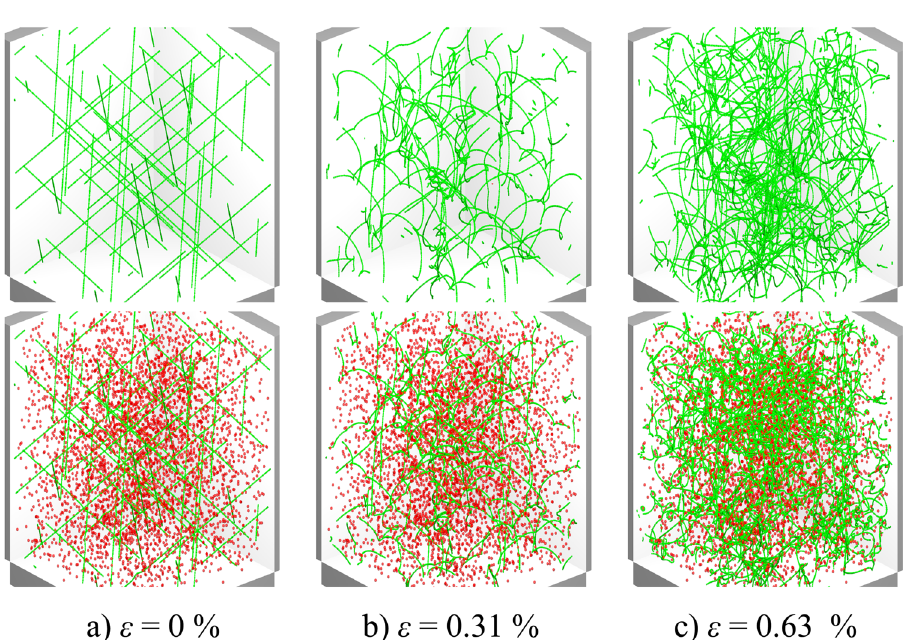
Figure 1. Snapshots of the initial and strained states of a dislocation system without precipitates (top) and of a system with hard precipitates (bottom). Precipitate density is ρ p = 5.0 × 10 21 m − 3 , and the size parameter of the precipitates is R p = 5